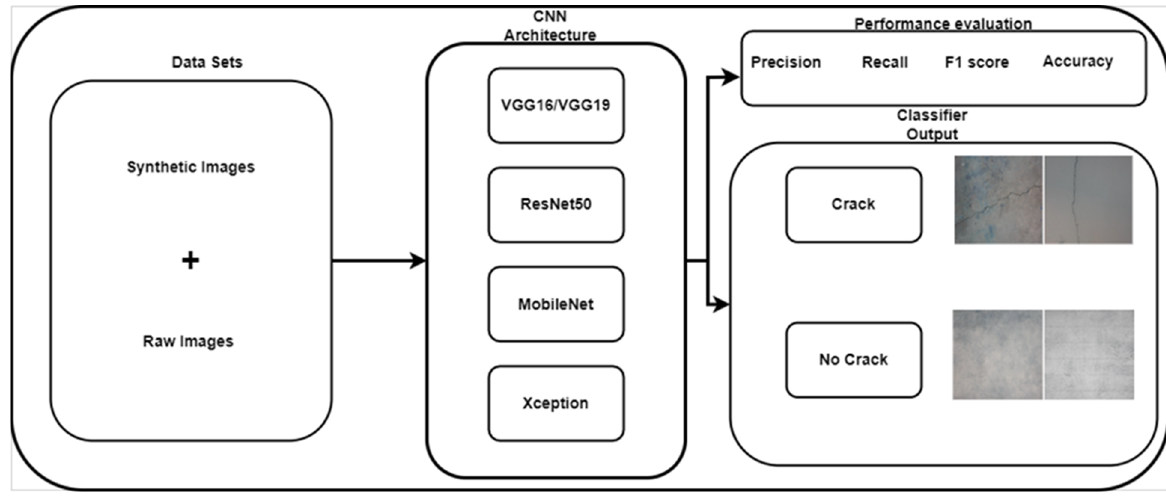
Figure 2. Framework for comparing di ff erent CNN models for classi fi cation of cracks.